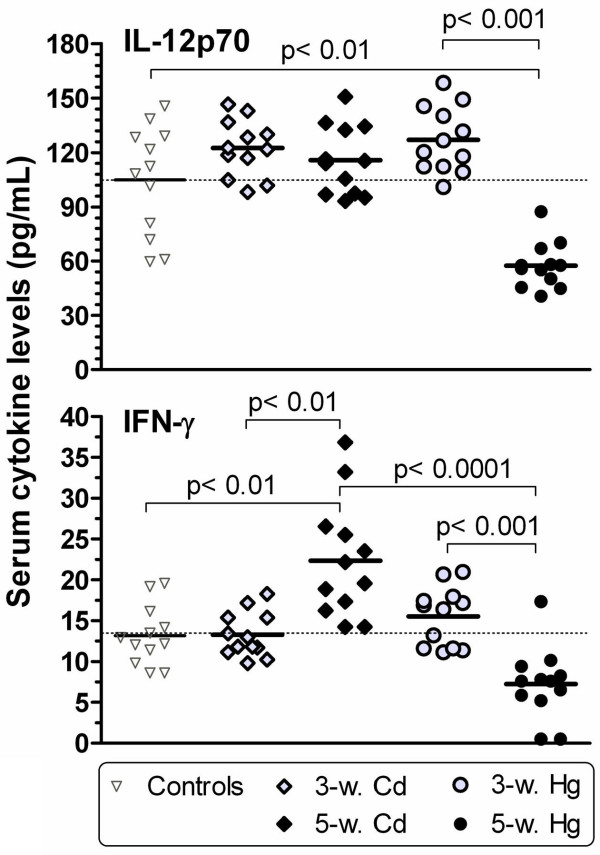
Serum profiles of IL-12p70 and IFN-γ in BALB/c mice exposed to heavy metals. Data represent cytokines levels following 3- (3-w) or 5-week (5-w) exposure to cadmium (Cd) acetate or mercuric (Hg) chloride as evaluated by cytometric bead array. The horizontal bars represent the medians of 12 samples. The dotted line represents the control level.